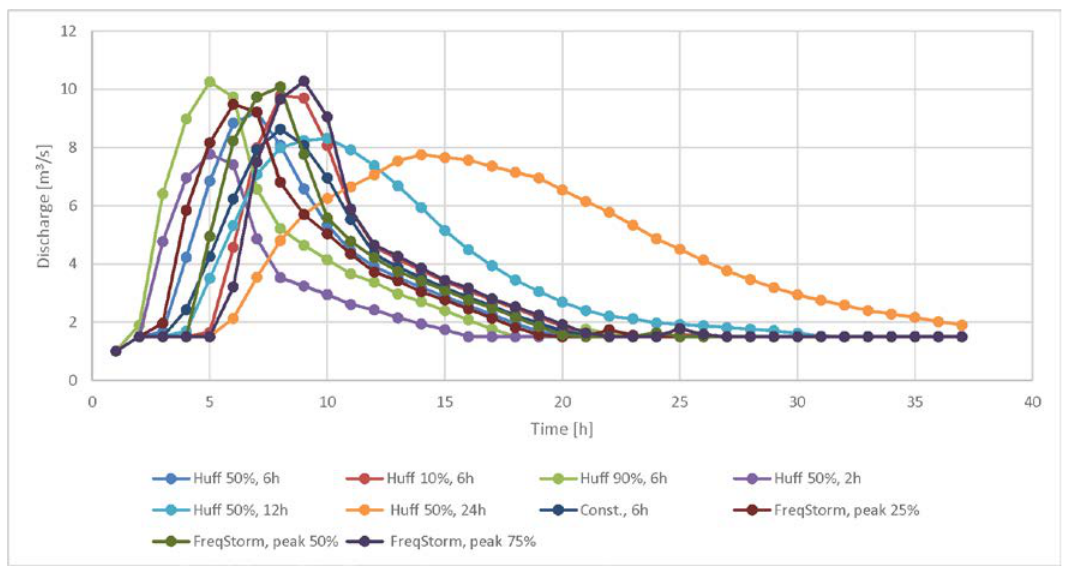
Figure 4. Comparison of outflow hydrographs for 10 selected scenarios for a 10-year return period.